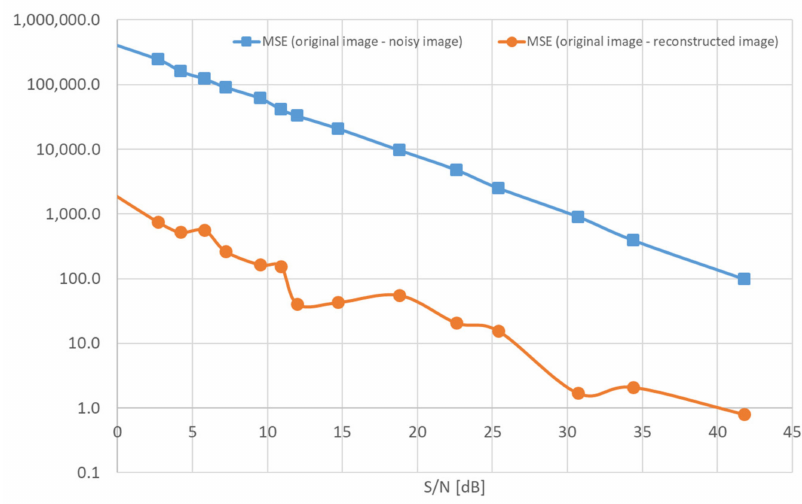
Figure 11. The plots of a function: MSE vs.